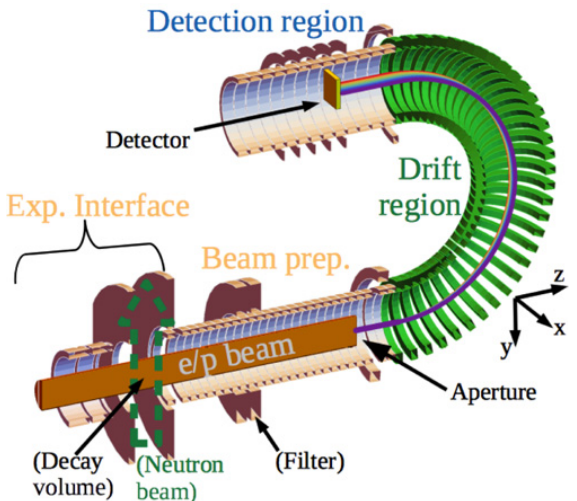
Figure 2. Scheme of NoMoS: The experimental set-up is divided into four areas: the experimental interface, the beam preparation area, the drift and the detector regions. Additional features in the standalone case are given in brackets. Particle beam: The electron/proton beam is magnetically guided and geometrically defined by the aperture. In the drift region the particles drift according to their momentum. The drift distance is measured in the detection